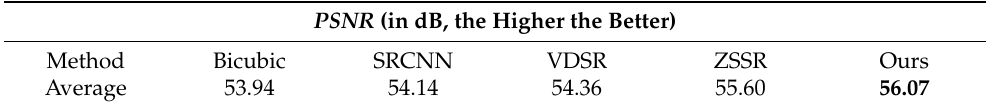
Table 2. PSNR for the test regions.